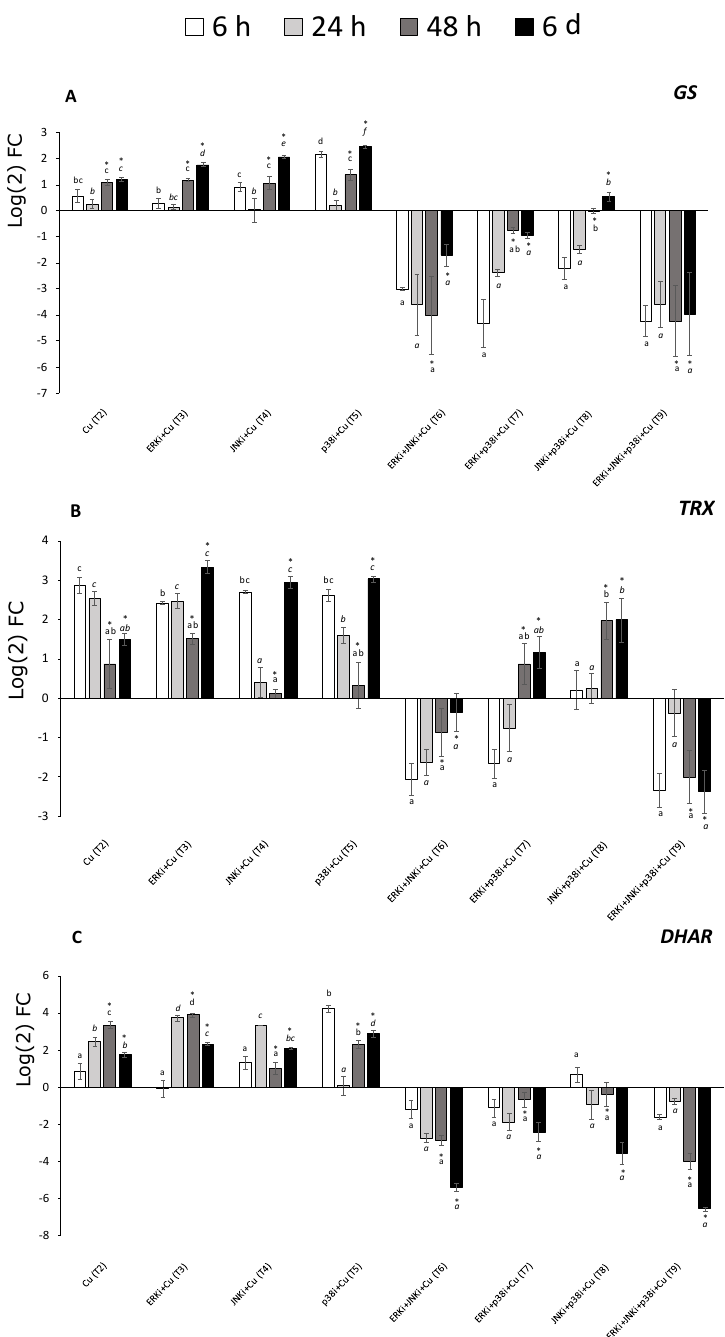
Figure 6. Relative expression of the genes glutathione synthase ( GS ; A ), thioredoxin ( TRX ; B ), and dehydroascorbate reductase ( DHAR ; C ) in U. compressa under copper and / or exposure to MAPK inhibitors. Expression was relative to the levels of transcripts in U. compressa under control conditions. Treatments consisted in: T1) solely copper exposure as 10 µM of CuSO 4 (Cu); T2) copper + 5 µM MAPK ERK inhibitor PD98059 (Cu + ERKi); T3) copper + 5 µM MAPK JNK inhibitor SP600125 (Cu + JNKi); T4) copper + MAPK p38 inhibitor SB203580 (Cu + p38i); T5) Cu + ERKi + JNKi; T6) Cu + ERKi + p38i; T7) Cu + p38i + JNKi; and T8) Cu + ERKi + JNKi + p38i. Samples were analysed after 6 h ( A ), 24 h ( B ), 48 h ( C ), and 6 d ( D ) treatments. Different letters, in italics and/or with asterisk represent significant difference at 95% confidence interval ( p < 0.05) within each experimental time. Plots are represented as mean ± SE ( n = 3).